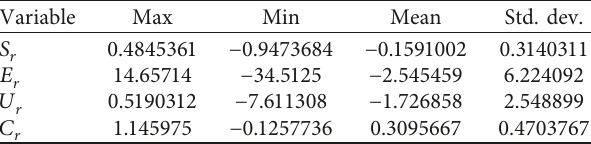
Table 3: Descriptive statistics of research variables. Variable Max Min Mean